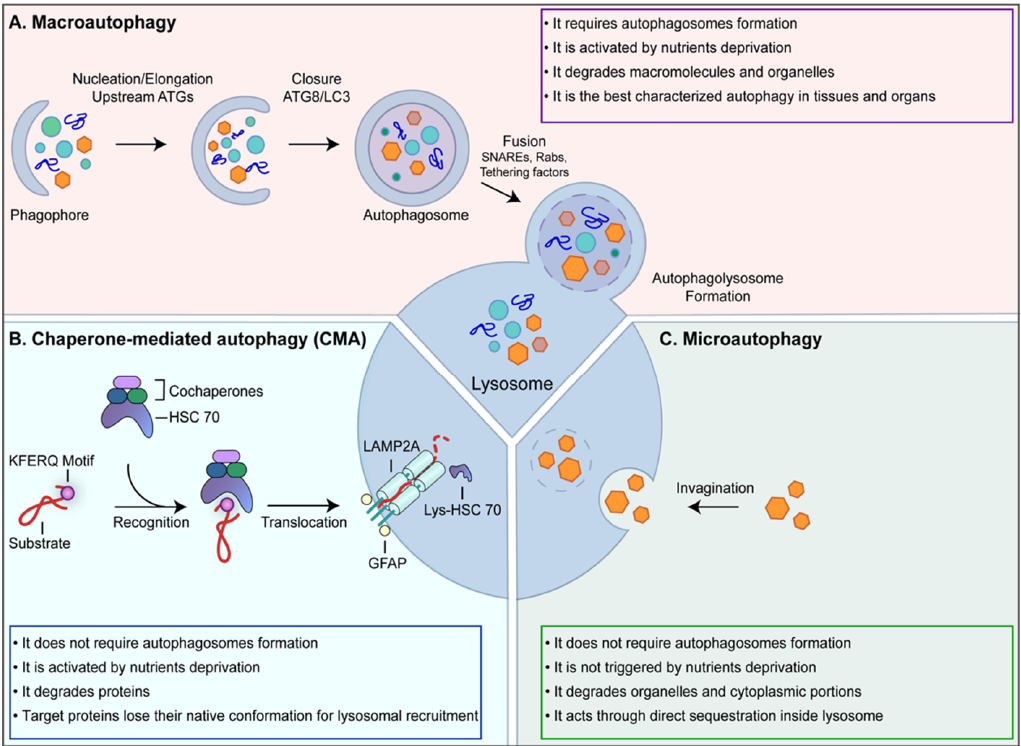
Figure 1. Autophagy machinery. Autophagy is a quality-control process aimed at eliminating old or damaged cellular components. ( A ) Macroautophagy is the most common form of autophagy. It requires different sequential steps leading to the formation of autophagosomes. Following the fusion between autophagosomes and lysosome, the cargo is degraded and the resulting macromolecules are released back into the cytosol to be recycled; ( B ) chaperone-mediated autophagy (CMA) contributes to the cellular homeostasis by recycling amino acids upon proteins degradation and by eliminating abnormal or damaged proteins. CMA targets are recognized by this molecular machinery as they contain the KFERQ motif; ( C ) Microautophagy is involved in organelles and cytoplasmic portions turnover through direct sequestration inside lysosomes.